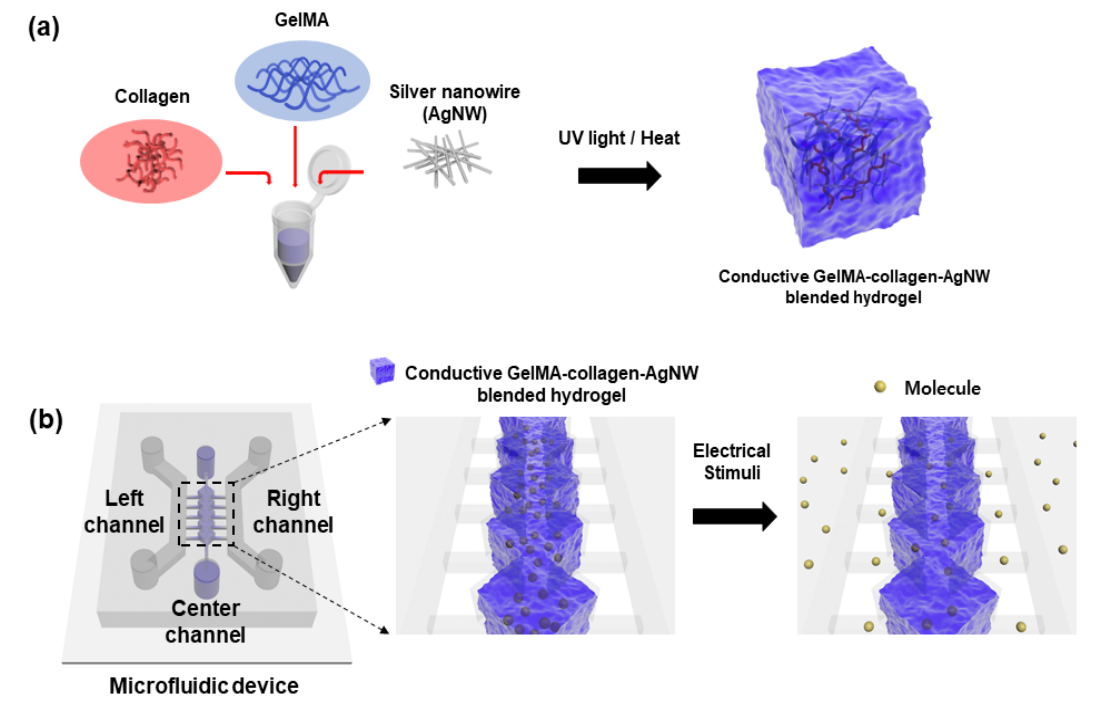
Figure 1. Schematic of the conductive gelatin methacrylate (GelMA)–collagen–silver nanowire (AgNW) blended hydrogel. The protocol for generating the conductive GelMA–collagen–AgNW blended hydrogel ( a ). Electrical stimuli-mediated molecule release from the conductive GelMA–collagen–AgNW blended hydrogel in the microfluidic device ( b ).